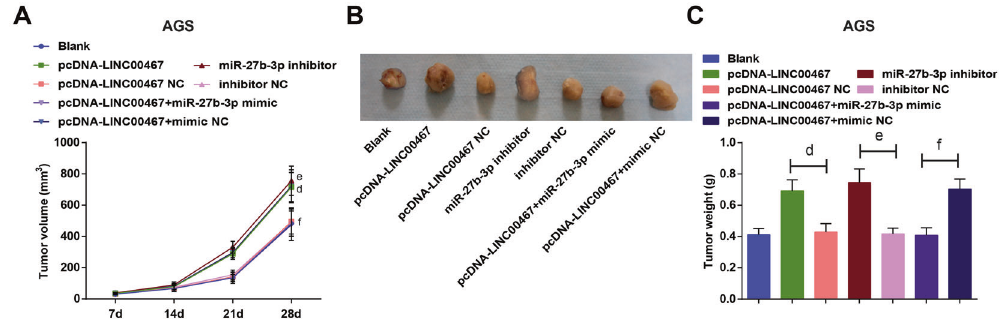
Fig. 6 Upregulation of LINC00467 or inhibition of miR-27b-3p accelerates GC tumor growth in vivo. A growth curve of AGS xenografts. B Representative images of AGS xenografts. C Weight of AGS xenografts in each group; d P < 0.05 vs the pcDNA-LINC00467 NC group, e P <